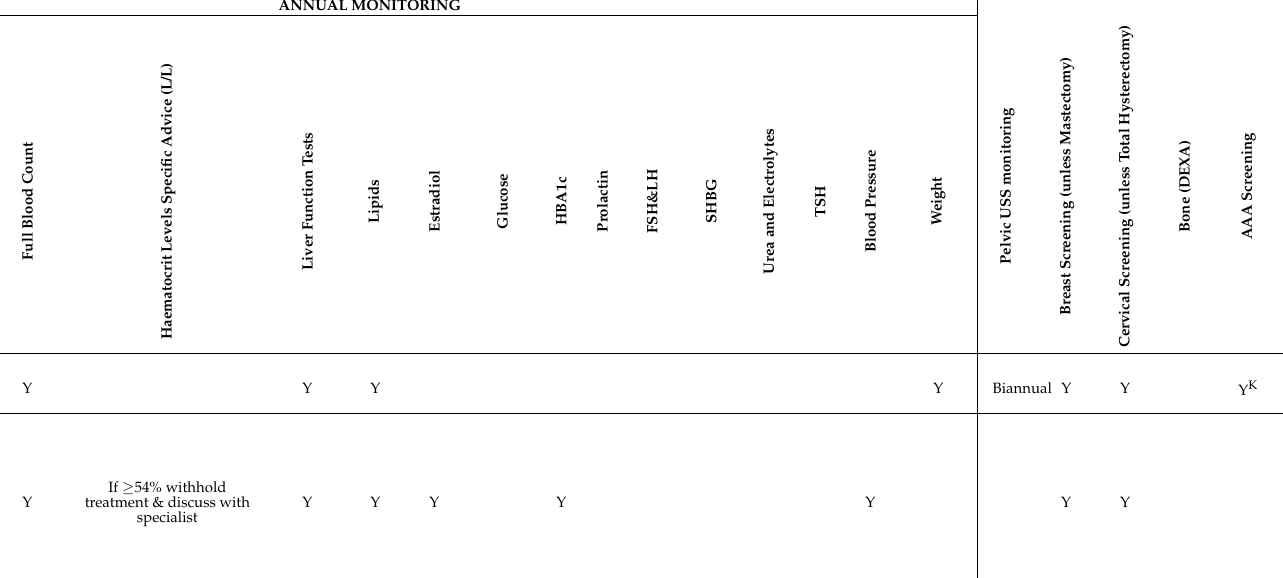
Table 1. Cont. Table 2. Comparison of national, international, and patient specific prescribing and monitoring guidelines for trans women (observed males at birth) with gender